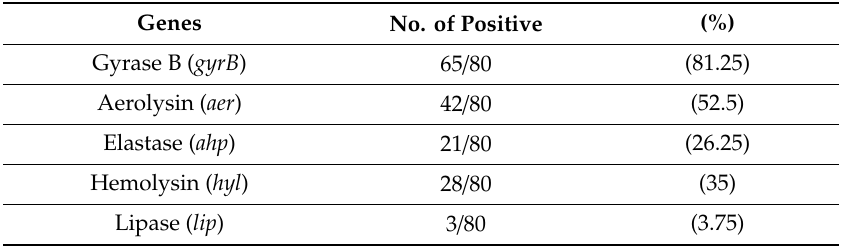
Table 6. Molecular characterization of motile Aeromonads isolates and their virulence